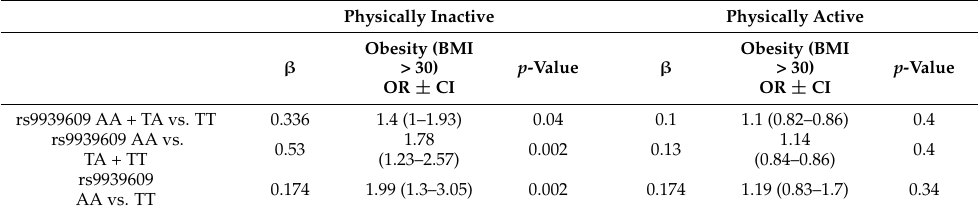
Table 4. Physical activity effect on FTO rs9939609 obesity risk.